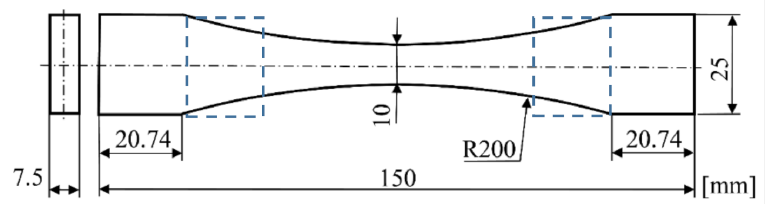
Figure 2. Specimen shape for simple and graded tensile